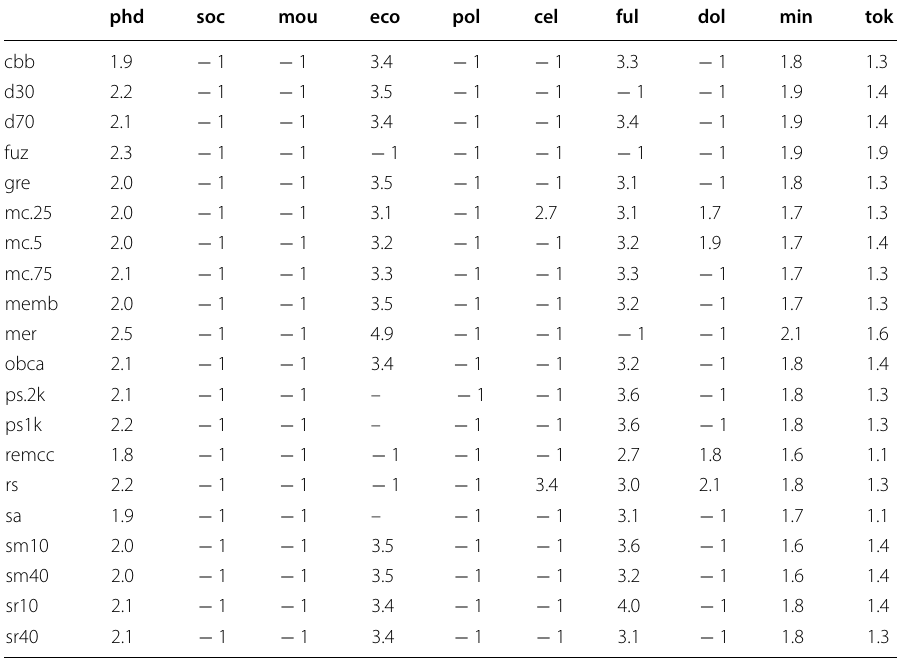
Table 6 Estimated d B values for the first